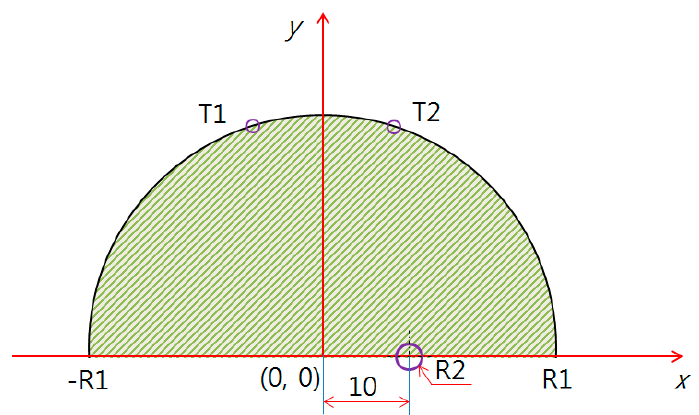
Figure 3. Defect position along the right-hand direction (X = 10, Y = 0).